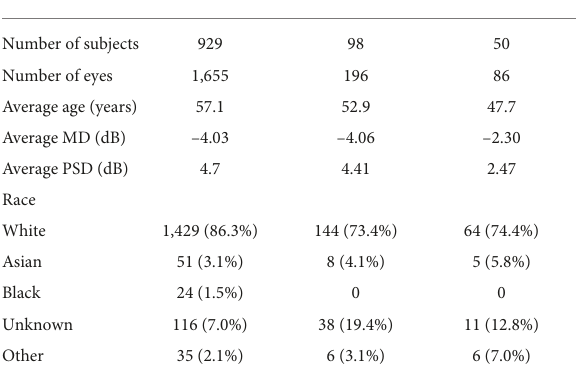
TABLE 1 Demographic characteristics of the